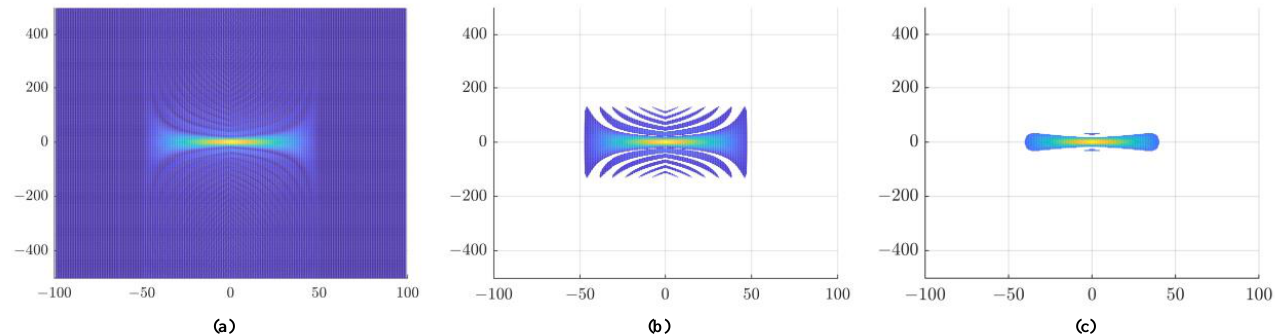
Figure 2. The contours of the ambiguity function. ( a ) Projection of the ambiguity function; ( b ) height is set to 0.1 times the peak of the ambiguity function; ( c ) height is set to 0.3 times the peak of the ambiguity function.